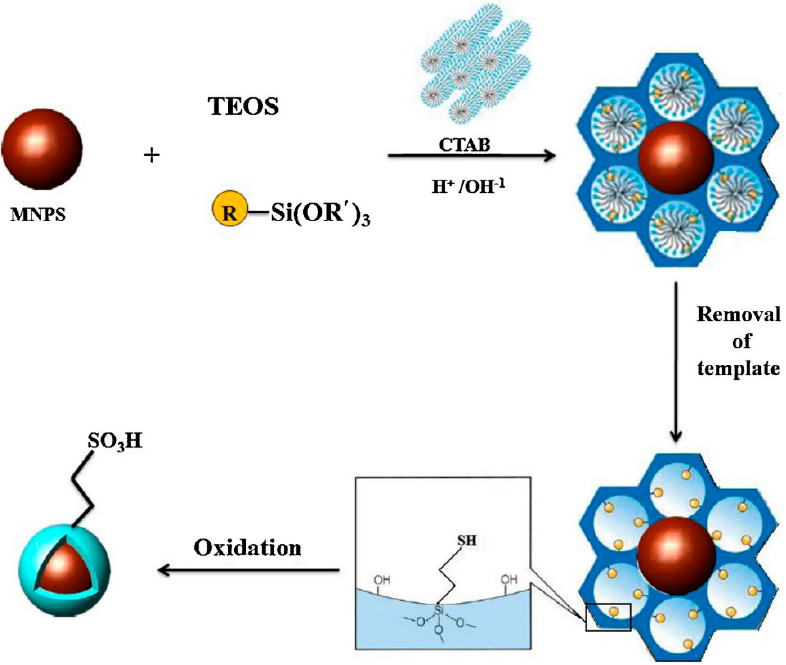
Figure 58. Synthesis of Fe 3 O 4 @MCM-41-SO 3 H by thiol oxidation (R:CH 2 CH 2 SH). Reproduced with permission from [154]. Copyright 2013 Elsevier B.V.